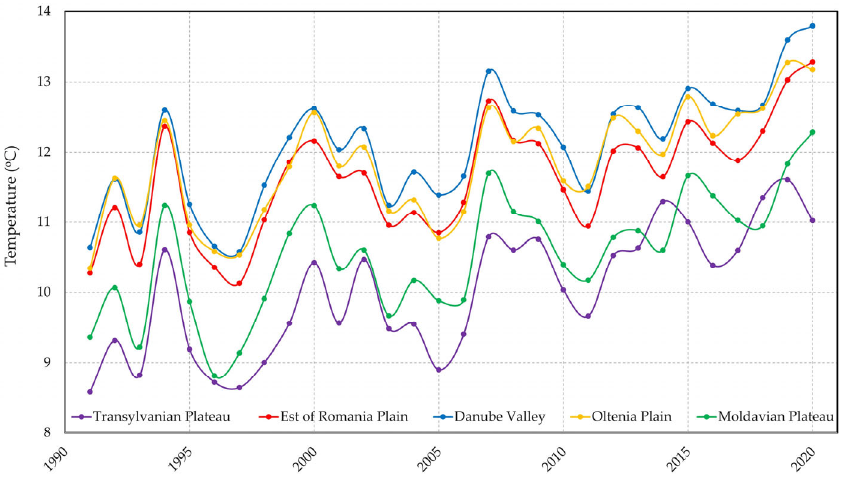
Figure 4. Temperature evolution in Romania during 1990–2020.